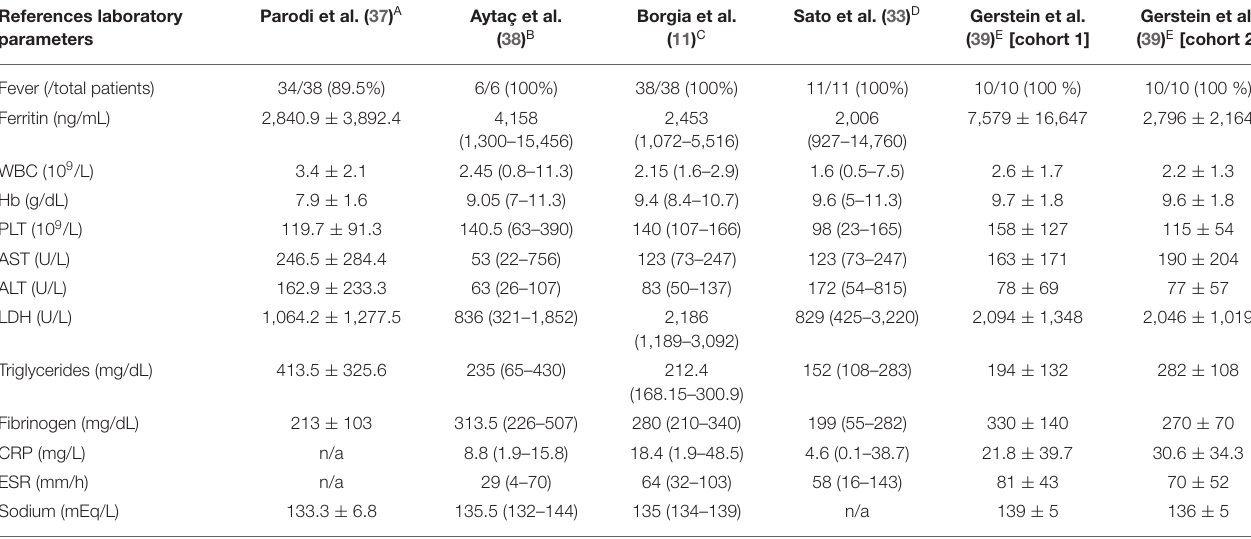
TABLE 4 | Relevant laboratory parameters for MAS diagnosis in pSLE patients, as reported in the available clinical